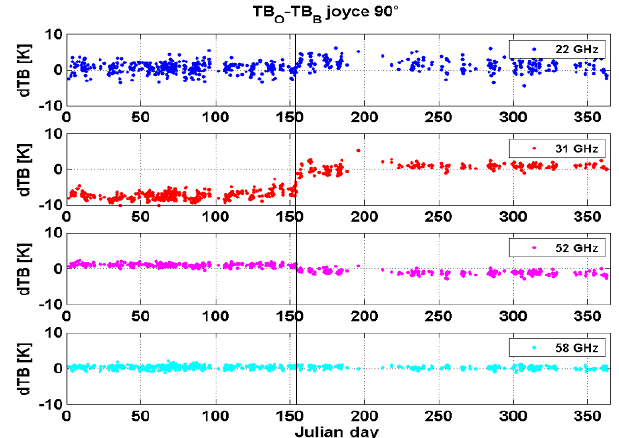
Figure 2. Time series of the O–B TB differences at JOYCE; from top to bottom: channels 22.24 (blue dots), 31.40 (red dots), 52.28 (magenta dots), and 58.00GHz (cyan dots). The black solid line represents the date of the new calibration (3 June